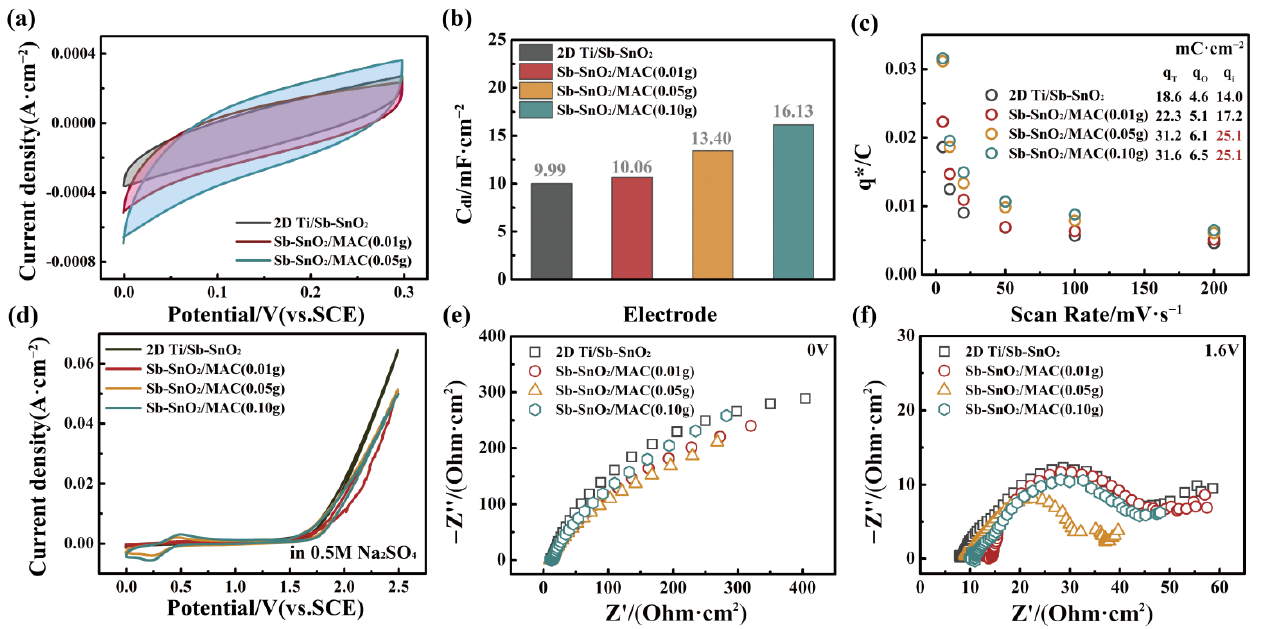
Figure 2. Electrochemical characterization results (in 0.5 M Na 2 SO 4 solution): ( a ) Narrow CV curves of 2D Ti/Sb-SnO 2 , Sb-SnO 2 /MAC(0.01 g), and Sb-SnO 2 /MAC(0.10 g) under potential scan rate of 0.005 V · s − 1 ; ( b ) C dl values; ( c ) Voltammetric charges caculated from the narrow CV curves; ( d ) Normal CV curves (0–2.5 V vs. SCE, potential scan rate: 0.01 V · s − 1 ); ( e ) Nyquist plots (equilibrium